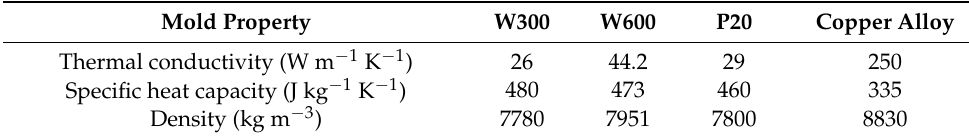
Figure 4. Mold configuration for the validation experiments. Table 3. Thermodynamic properties of the mold materials used for experimental validation.